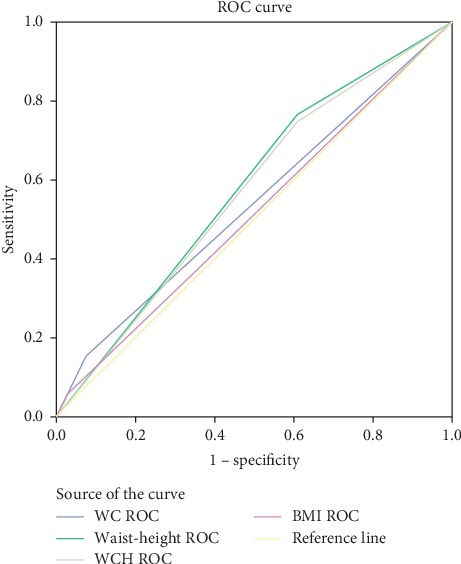
Receiver operating characteristic curve of body mass index (BMI), waist circumference (WC), waist-hip ratio (WHR), waist-to-height ratio (WHtR), and waist-to-square height ratio (WHt2R) to prediabetes in male.